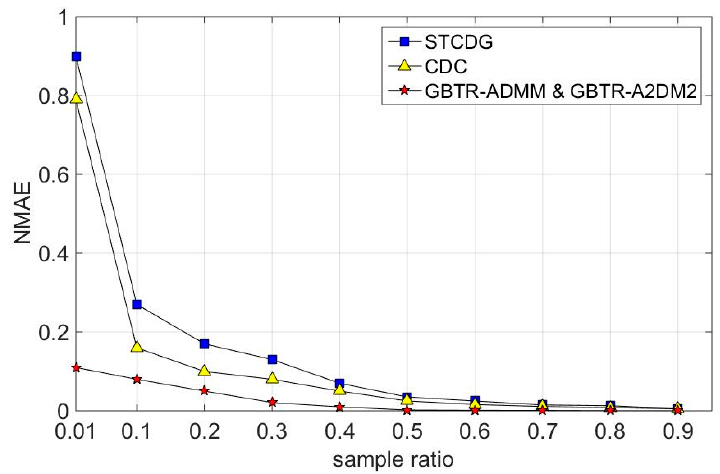
Figure 7. Recovery errors on humidity dataset.